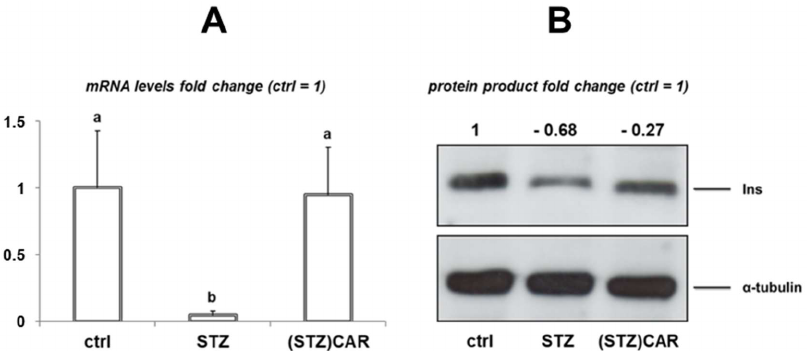
Figure 2. Expression of the insulin gene products in the pancreas tissue. 2A : qPCR analysis of the Ins1 mRNA. Ctrl: untreated control mice; STZ: hyperglycemic mice; (STZ)CAR: hyperglycemic mice orally administered with CAR. Expression of the mRNA target is obtained from the value of the 2 − ∆ C t function ( C t , Threshold cycle) normalized respect to the 28S RNA according to Schmittgen and Livak [25]. Values refer to the mean data ( ± S.E.M.) from n = 5 individuals and are expressed as fold change with respect to control (fold change 1). Statistical analysis: one-way ANOVA, post hoc test by Bonferroni; different letters (a, b) indicate significantly different values ( p <0.05). 2B : representative Western blot assay for the insulin protein product (Ins) in the protein extract from the pancreas. For each sample lane, the densitometric quantification of the Ins product band refers to the mean data from n = 3 individuals. Mean values have been normalized respect to the corresponding α -tubulin